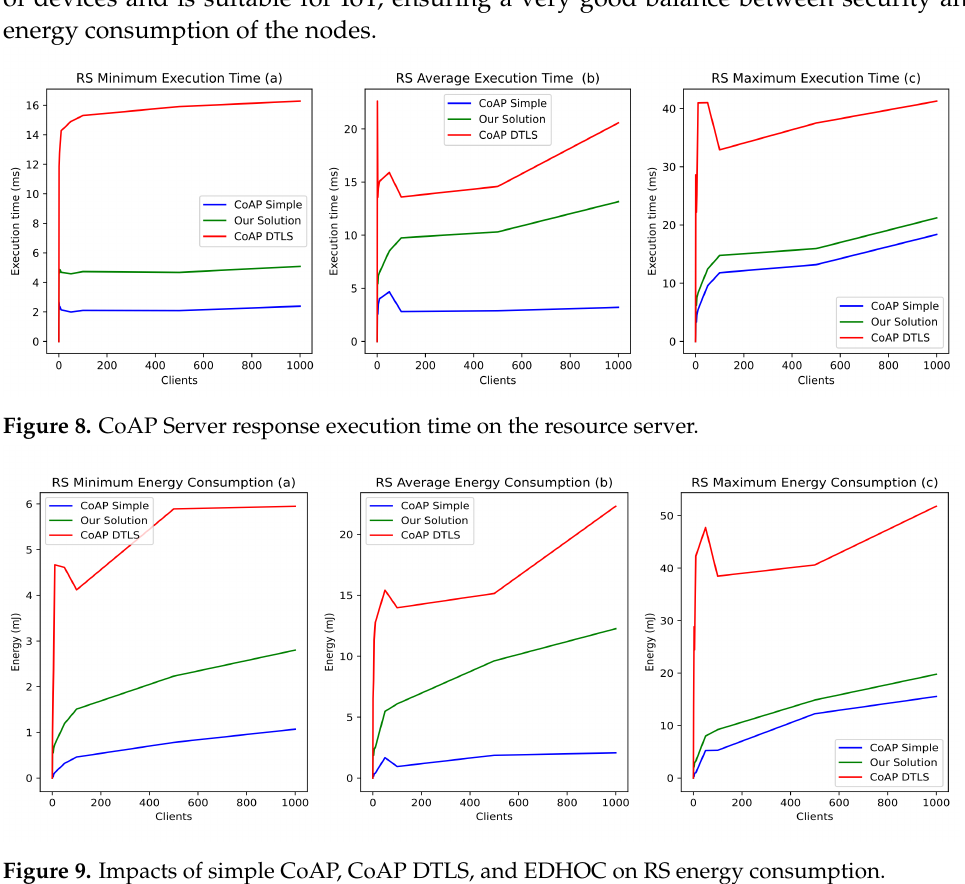
Figure 9. Impacts of simple CoAP, CoAP DTLS, and EDHOC on RS energy